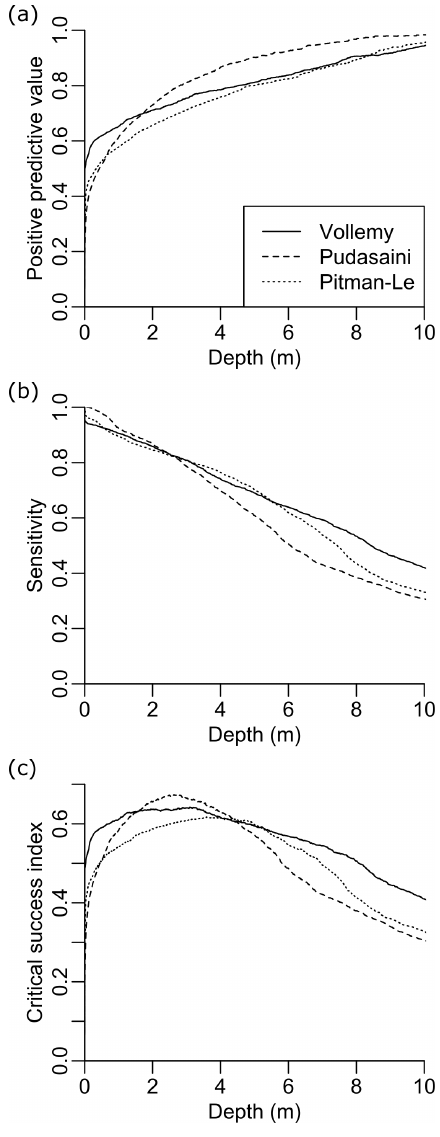
Figure 5. Flow outline performance with depth for Voellmy– Salm (solid line), Pudasaini (2012) (dashed line), and Pitman and Le (2005) (dotted line) flow models. Performance metrics are (a) positive predictive value (PPV), (b) sensitivity, and (c) critical success index